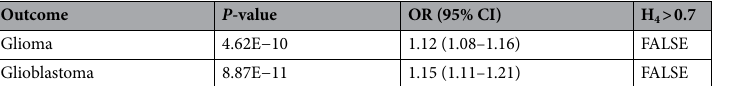
Table 7. The Mendelian randomization results for the analysis of differential gene expression in brain with glioma and glioblastoma risk. P-adjusted, p-value adjusted for FDR. MR effect estimates are reported as odds ratios (OR) (95% confidence intervals (CI)) per 1 standard deviation change in differential gene expression.